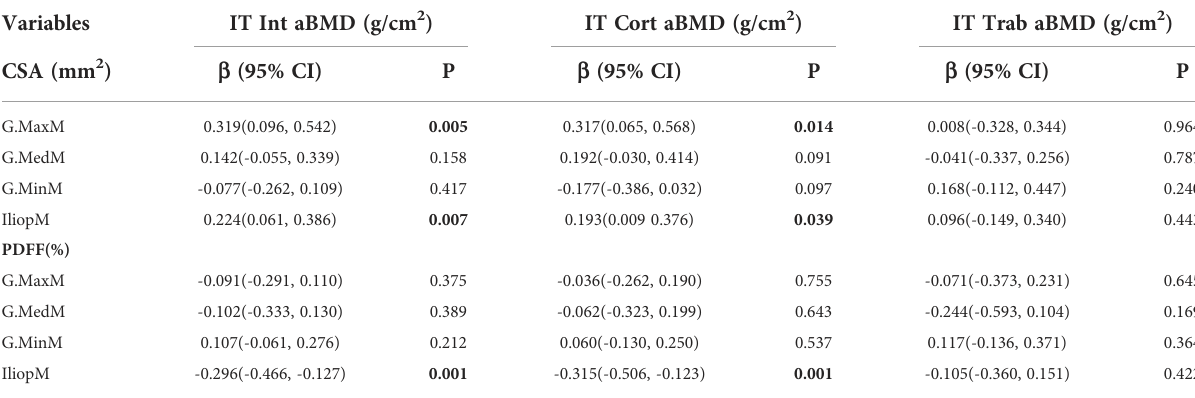
TABLE 6 Generalized multiple linear standardized regression coef fi cients and 95% CIs between the aBMD of the IT and various muscle indexes a,b, c in males.